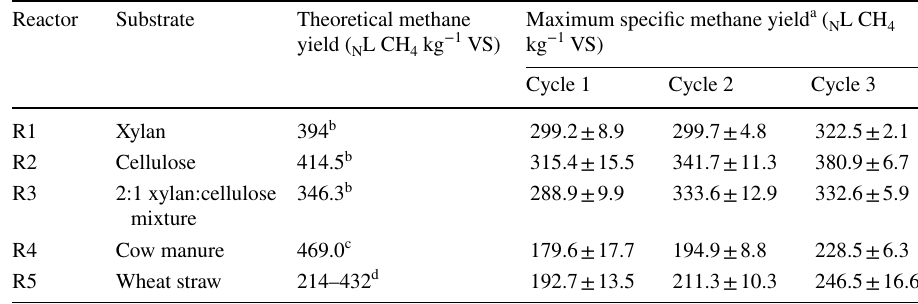
Table 2 Specific methane yield for xylan cellulose, cow manure and wheat straw